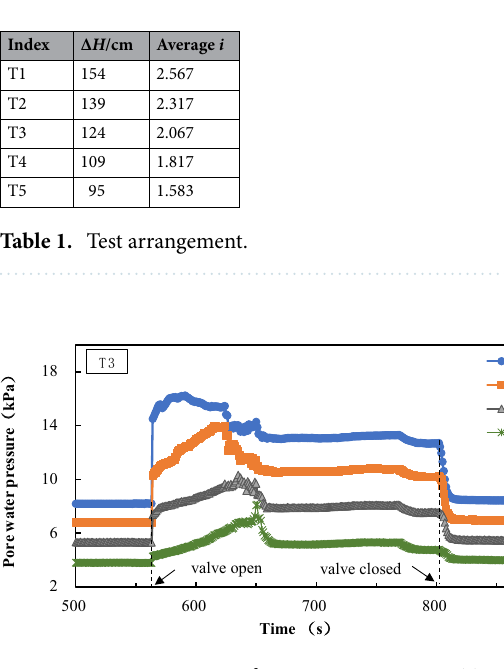
Figure 3. Variation curve of pore water pressure in